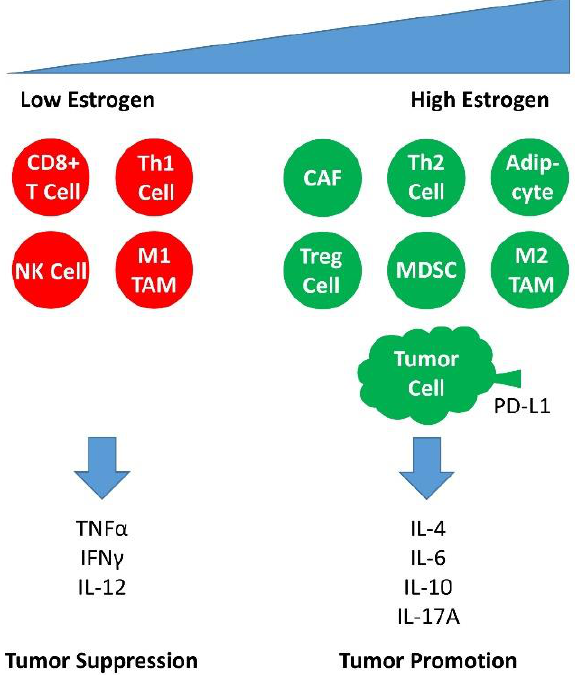
Figure 3. Pro- and anti-tumoral effects of members of the tumor microenvironment on the immune microenvironment of cervical intraepithelial neoplasia and malignancy, respectively, as a function of estrogen concentration. Depending on the strength of estrogen signaling, cells of the innate and adaptive immune response are modulated according to the communication between them and depending on their cytokine levels in such a way that they support either tumor suppression or progression. This battle between the subtypes of immune cells determines whether the tumor progresses or is eliminated by the immune system. The tumor-suppressive arm consists of CD8+ (cytotoxic) T cells, Type 1 T helper cells (Th1 lymphocytes), natural killer (NK) cells, type 1 tumor-associated macrophages (M1 TAMs). The tumor-promoting arm consists of cancer-associated fibroblasts (CAFs), Type 2 T helper cells (Th2 lymphocytes), adipocytes, regulatory (suppressive) T cells (Tregs), MDSCs, type 2 tumor-associated macrophages (M2 TAMs), Tumor cells. IFN γ , Interferon gamma; TNF α , tumor necrosis factor alpha; IL, Interleukin; PD-L1, Programmed cell death 1 ligand